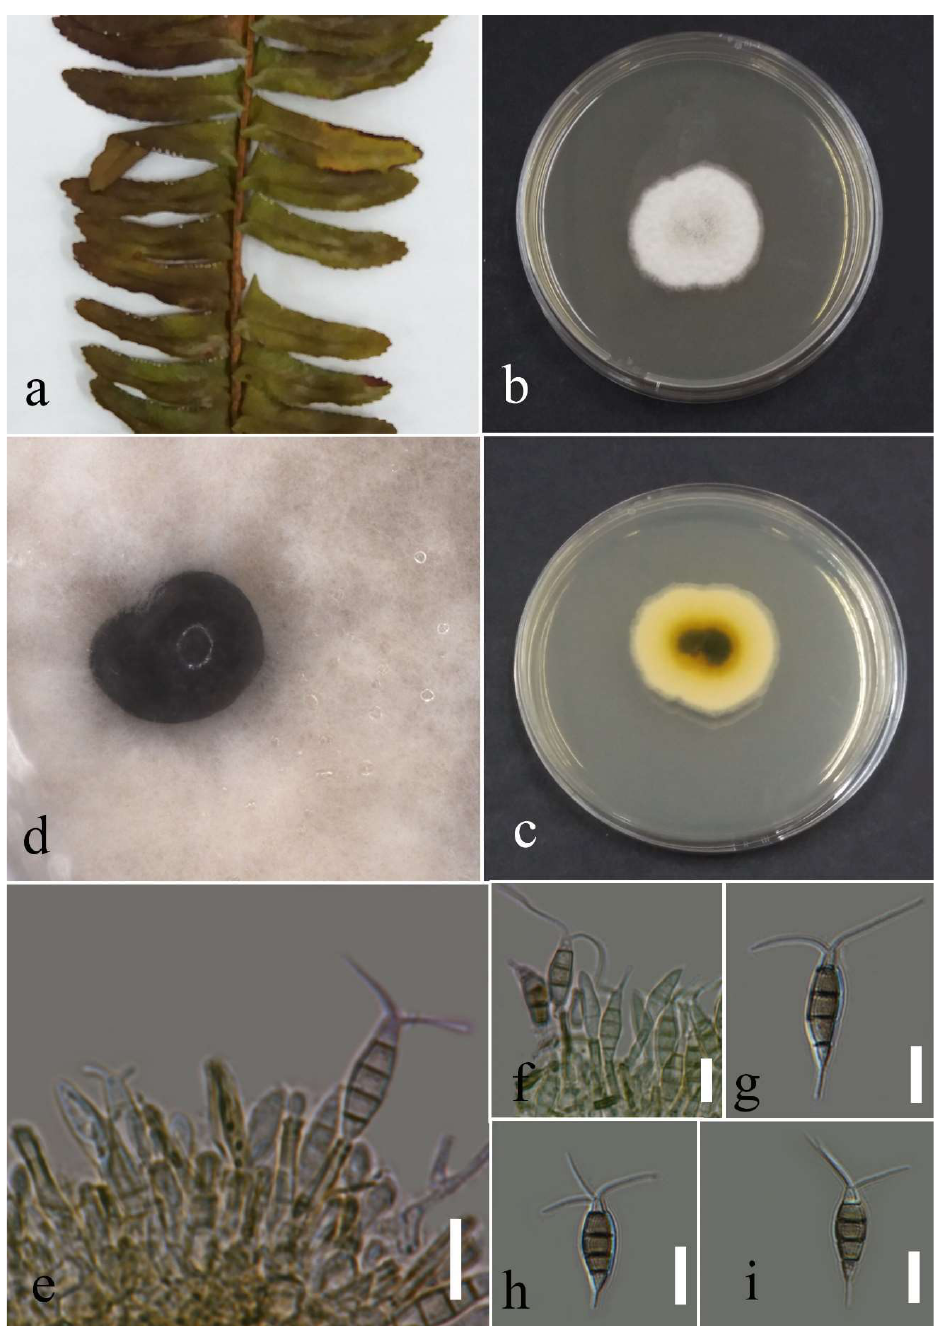
Figure 14. Morphology of Pestalotiopsis dracontomelon (MFLUCC 22 - 0145): ( a ) blight in Nephrolepis cordifolia ; ( b , c ) upper and reverse views of the colony after seven days of growth on PDA at 28 °C; ( d ) conidiomata; ( e , f ) conidiogenous cells; ( g – i ) conidia . Scale bars = 10 µm . Pestalotiopsis hydei Huanraluek & Jayaward., 2021. Facesoffungi number: FoF 09460; Figure 15. Associated with Cyclosorus sp. leaf spot. Sexual morph: not observed. Asexual mass. Conidiphores reduced to conidiogenous cells. Conidiogenous cells lageniform